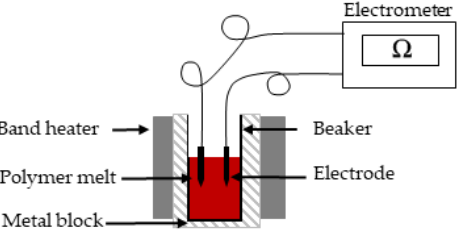
Figure 2. Electrometer apparatus for the analysis of electrical resistance in the PBS melt.